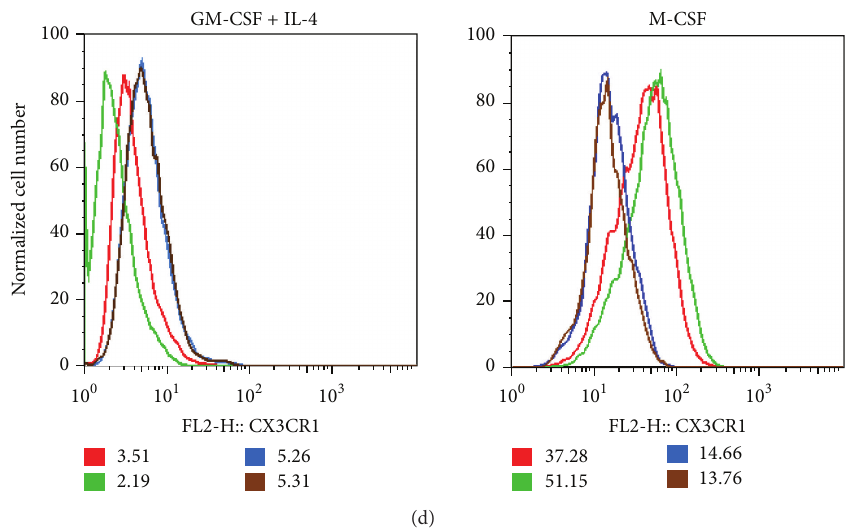
Figure4:ATRApromotestheexpressionofCD103 + cellsin invitro differentiatedmyeloidcells.Monocytesweredifferentiatedinthepresence of GM-CSF+IL-4 or M-CSF, respectively. The differentiated cells were treated by the supernatants of Caco2 cells preactivated by IL-1 𝛽 or TNF- 𝛼 in the presence or absence of ATRA. The phenotype of the myeloid cells was characterized by measuring the cell surface expression of 𝛼 4 𝛽 7/CD103 and CX3CR1 on day 3 of in vitro myeloid cell differentiation by flow cytometry. Histograms show the cell surface expression of CD103 in cells differentiated by GM-CSF+IL-4 (or M-CSF) and stimulated by the supernatants of Caco2 cells pretreated by IL-1 𝛽 (a) or TNF- 𝛼 (b) and the cell surface expression of CX3CR1 in cells differentiated by M-CSF (or GM-CSF+IL-4) and stimulated by the supernatants of Caco2 cells prestimulated by IL-1 𝛽 (c) or TNF- 𝛼 (d). MFI of a typical measurement out of 3–5 independent experiments is shown. Red line depicts untreated cells, green is for cells pretreated with the supernatant of Caco2 cells activated by IL-1 𝛽 or TNF- 𝛼 , blue is for myeloid cells pretreated with the supernatant of Caco2 cells activated by IL-1 𝛽 or TNF- 𝛼 in combination with ATRA, and brown corresponds to cells treated by the supernatant of unstimulated Caco2 cells and ATRA.